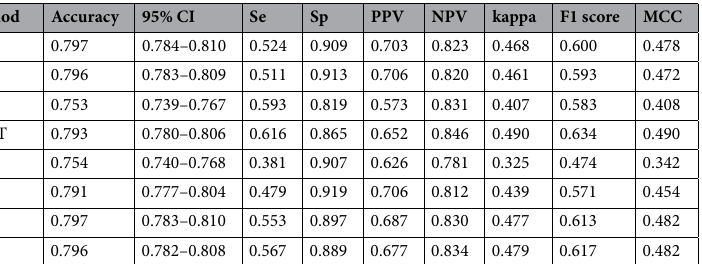
Table 1. Methods performance metrics [accuracy and 95% confidence interval (CI), sensitivity (Se), specificity (Sp), positive predictive value (PPV), negative predictive value (NPV), kappa, F1 score and Matthew’s Correlation Coefficient (MCC)] on external validation set. Prediction models were developed within different methods: Linear Discriminant Analysis (LDA), Generalized Linear Model (GLM) with logit link function, Naïve Bayes (NB), Classification and Regression Trees (CART), k-Nearest Neighbors (kNN), Support Vector Machines (SVM), Random Forest (RF) and Neural Network